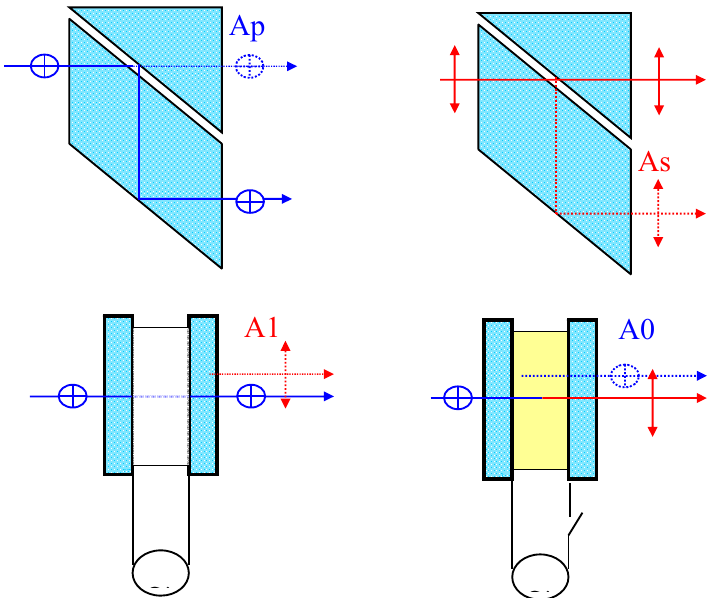
Figure 8. D ifferent cross talk sources: two are from FLCs and two from lateral beam splitters (LBSs).